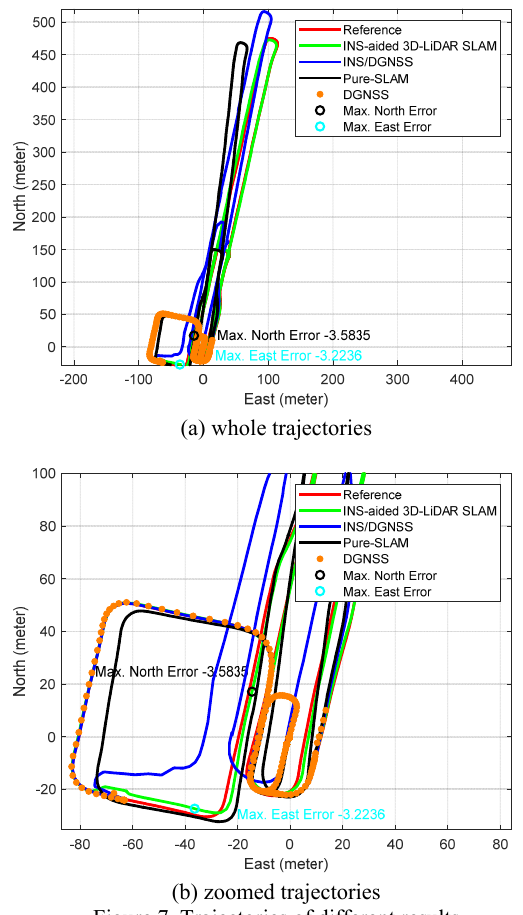
Figure 7. Trajectories of different results